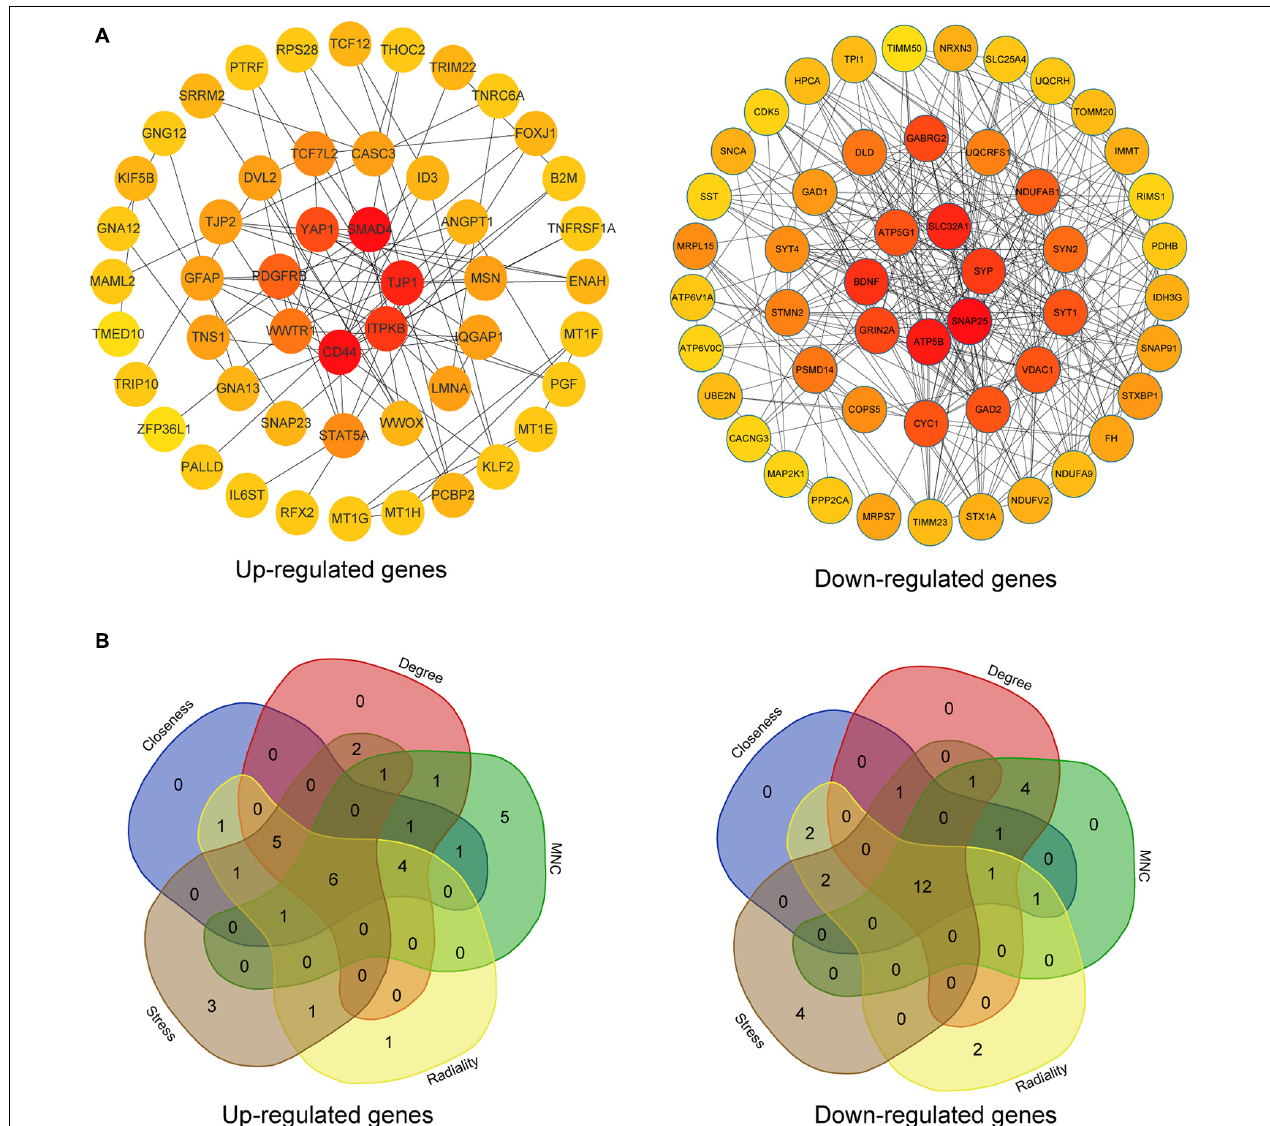
FIGURE 4 | PPI network and hub gene selection. (A) The top 50 hub genes in the PPI network of the upregulated and downregulated DEGs according to node degree. (B) Hub genes were identified by overlapping the first 20 genes in the five classification methods of